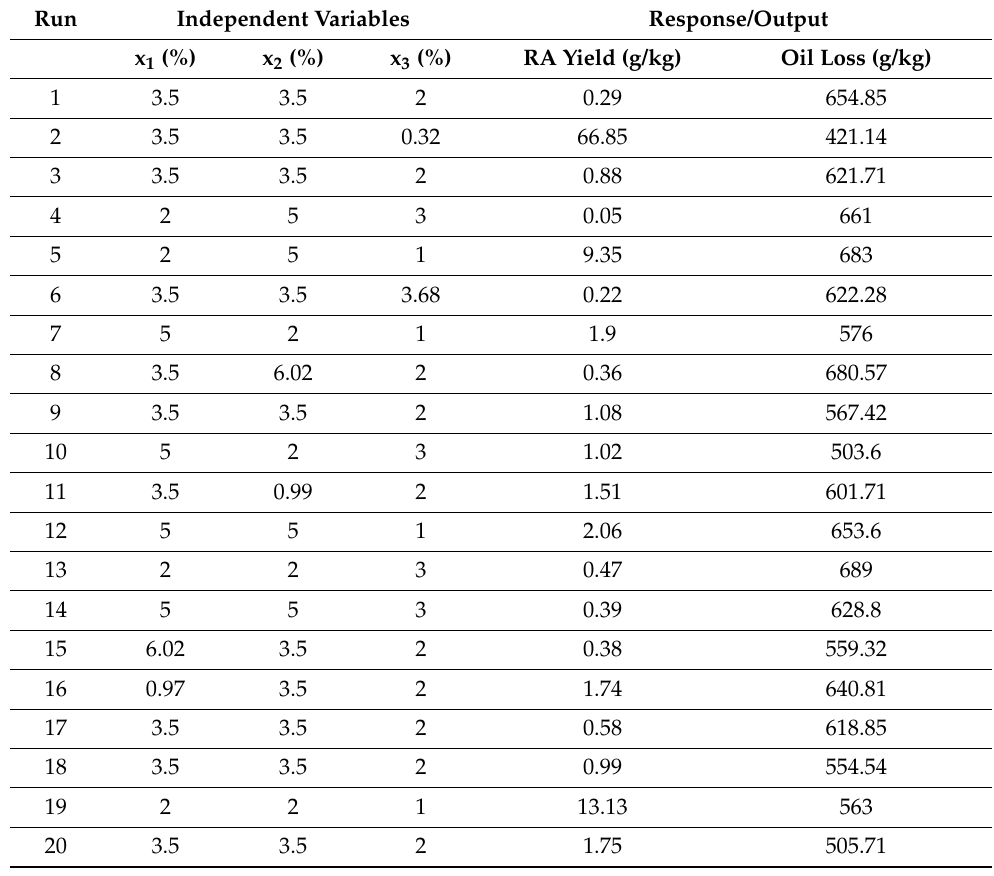
Table 2. CCD matrix for predictor (process) variables with output values of ricinoleic acid yield (g/kg), and oil loss (g/kg).